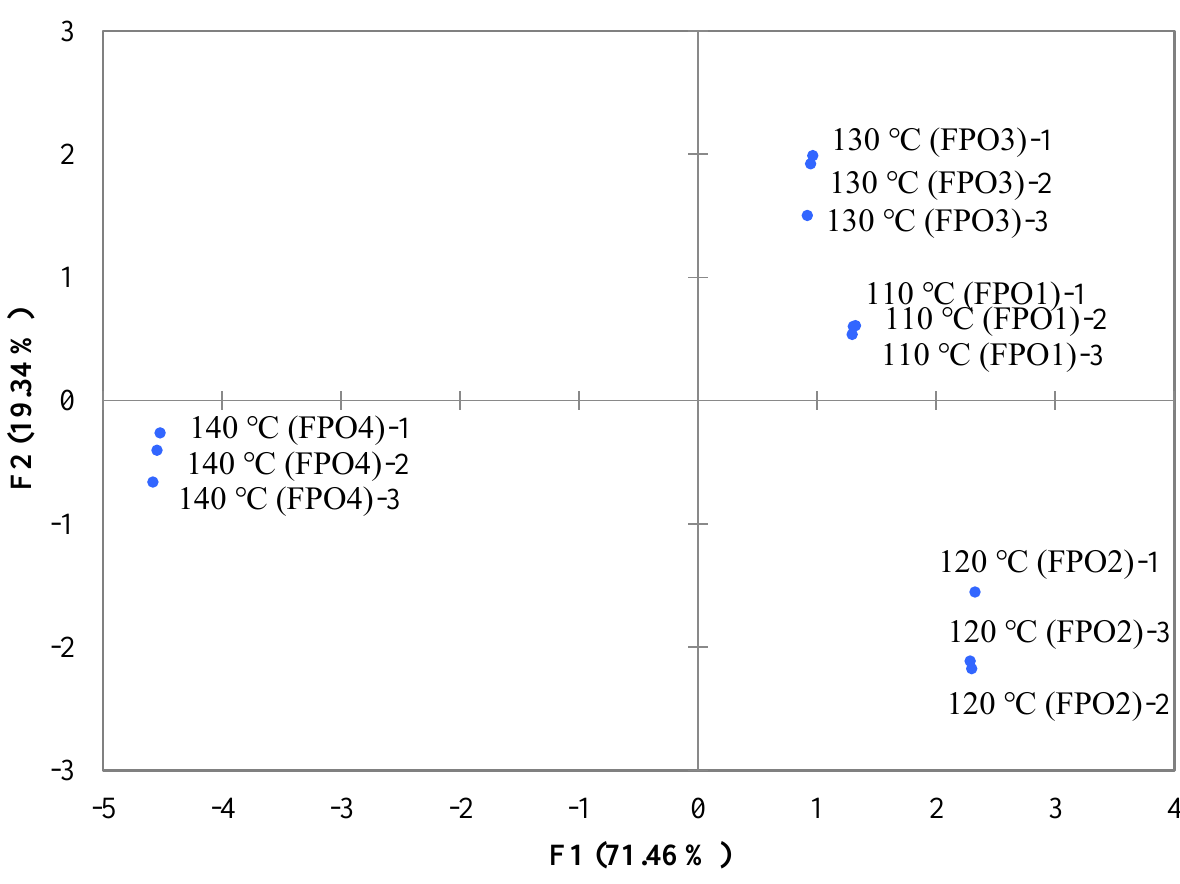
Figure 2. PCA chart for aroma profiles of FPOs with different frying temperatures.